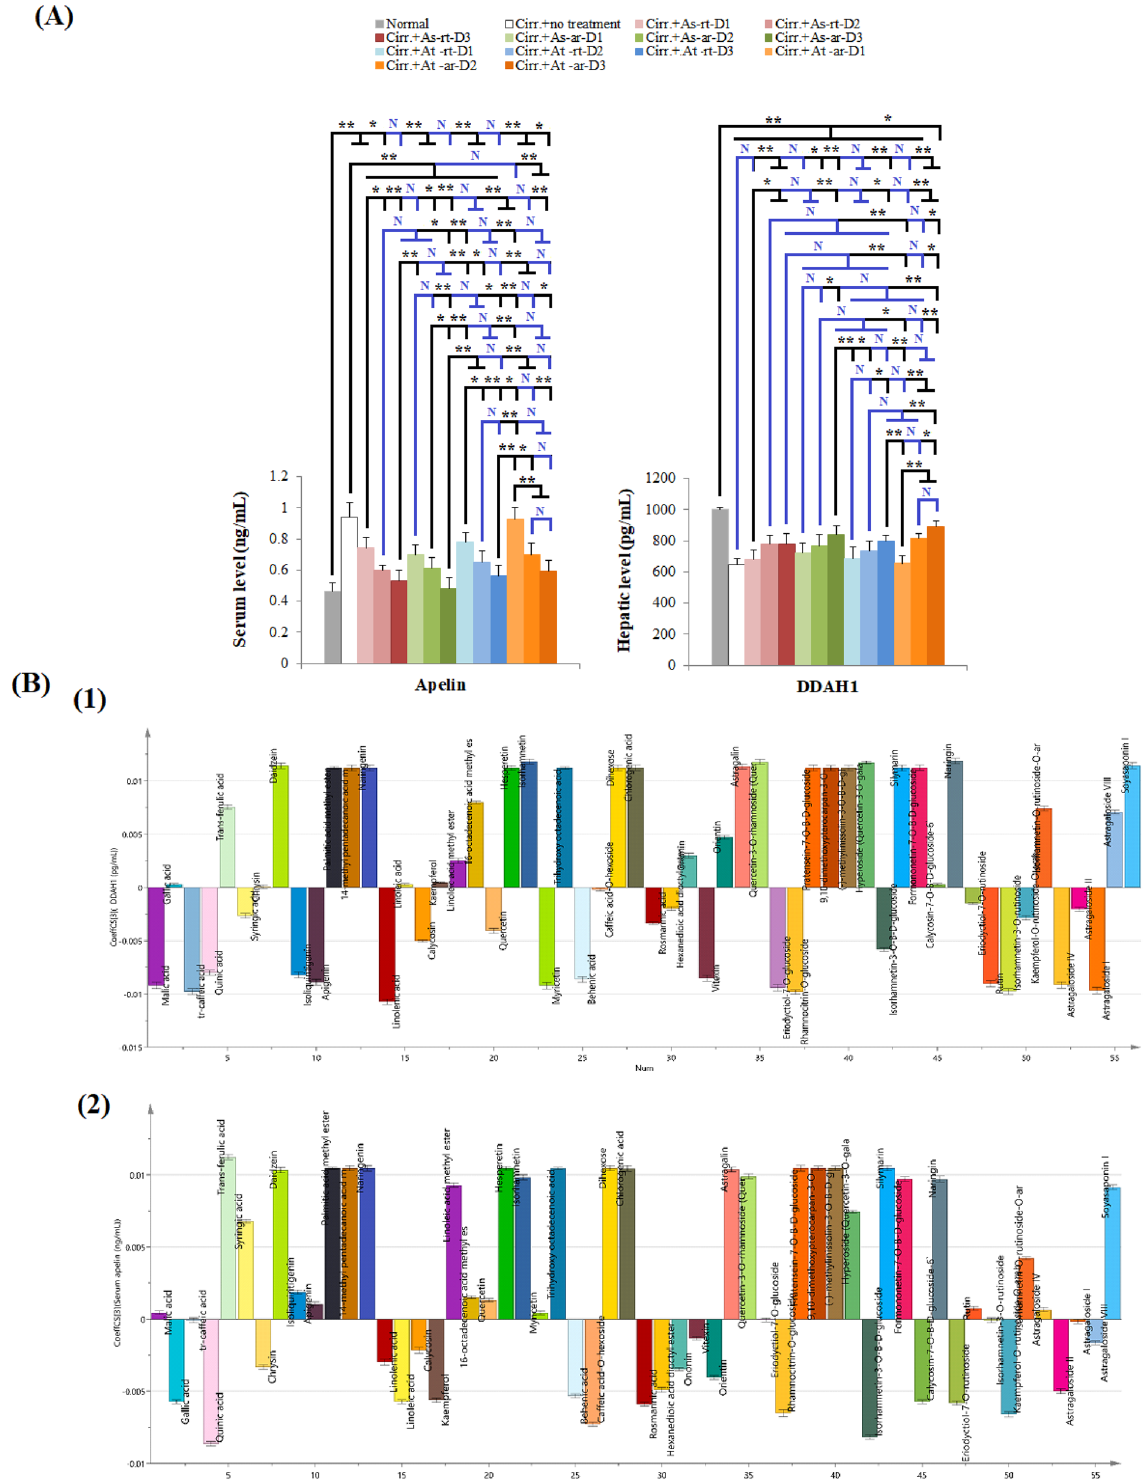
Figure 8. The effect of different Astragalus extracts on portal hypertension markers and their coefficient plot of OPLS model. ( A ): Effect of different Astragalus extracts on PH markers, ( B ): Coefficient plot of OPLS model for PH markers; (1) apelin (2) DDAH-1. ANOVA test was used to compare between the different groups with Post Hoc Test (Tukey) to compare different groups. *: Statistically significant at p ≤ 0.05, **: Statistically significant at p ≤ 0.001, N: Statistically non-significant ( p > 0.05), n = 8; all results are presented as mean ± SD. (Cirr.: induced cirrhosis by i.p. administration of